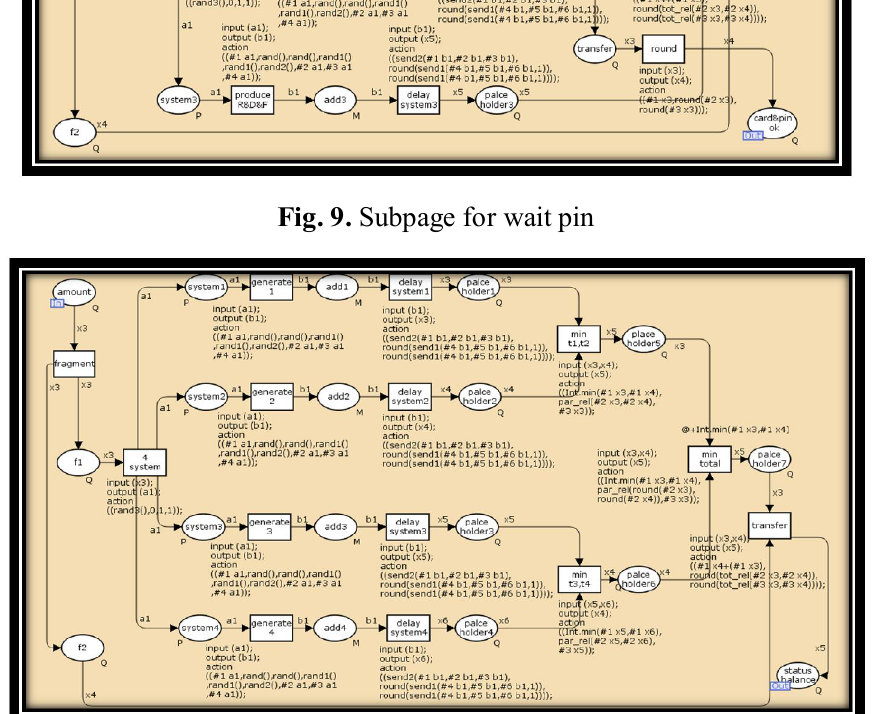
Fig. 10. Subpage for check balance